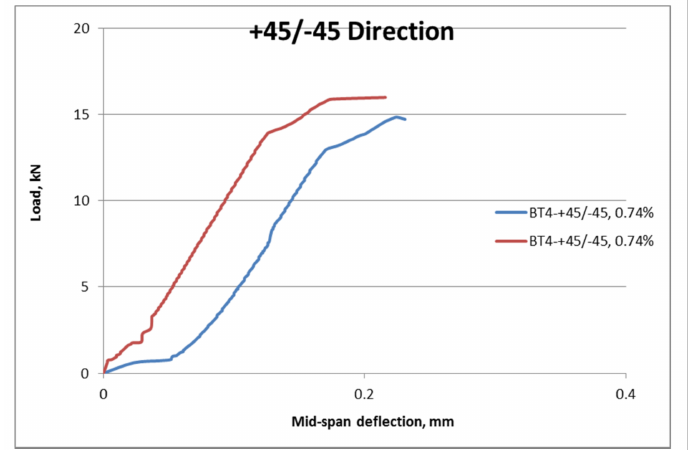
Figure 11. Mid-span load-deflection of TRC beams with woven fabric (2.5 cm) at ± 45 ◦ direction.